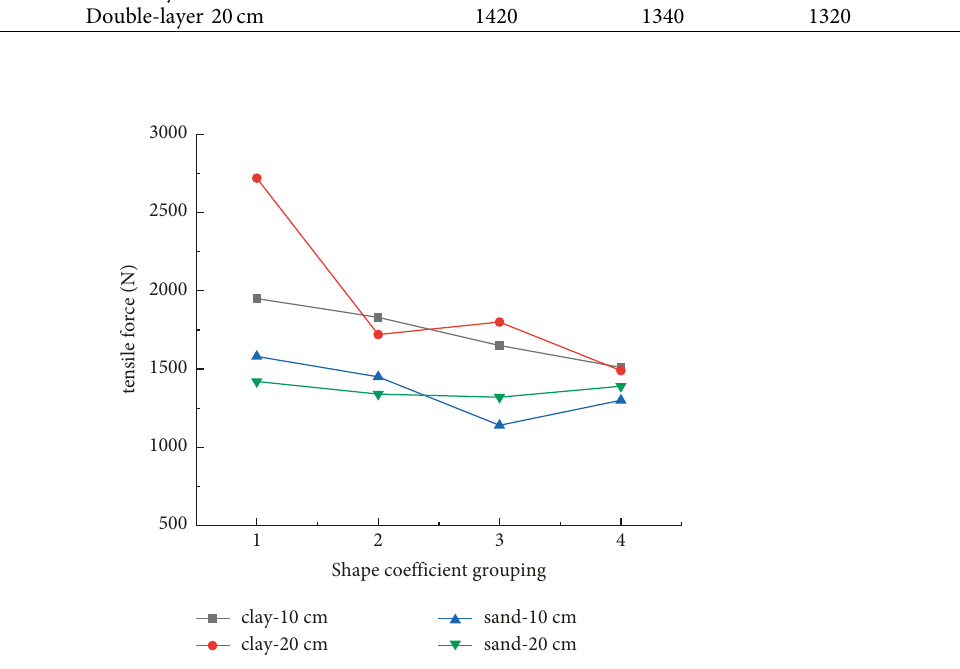
Figure 12: A representative value of tension in the pull-out test. Table 5: Top plate inclination angle of pull test ( °